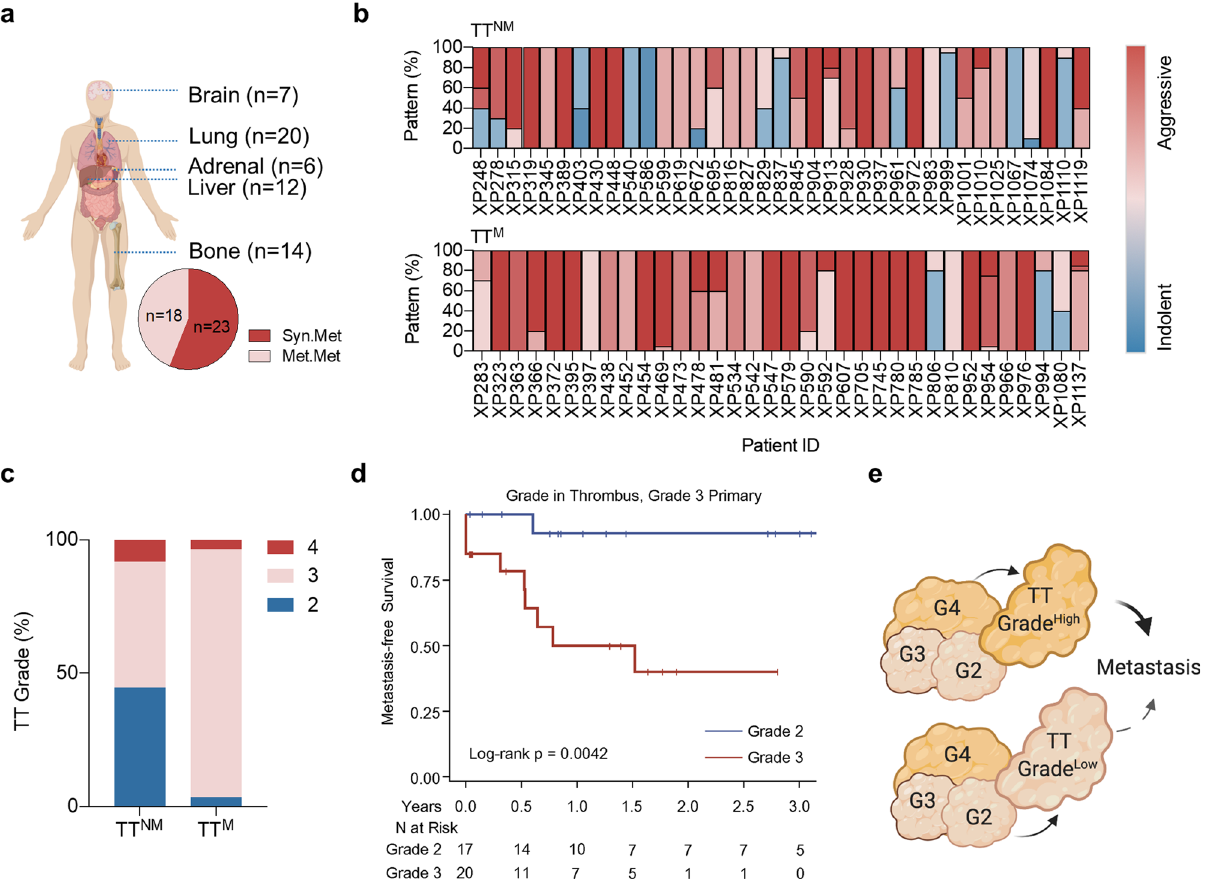
Fig. 4 Tumor thrombus grade predicts metastatic outcome. a Metastatic sites in RCC patients with TT in this cohort. b Tissue architectural patterns are for TT. c Grade distribution in TT M compared to TT NM . d Metastasis-free survival of patients with grade 3 PT classi fi ed according to TT grade. Kaplan – Meier (log rank) test. e Illustration highlighting higher metastatic incidence in RCC patients with high TT